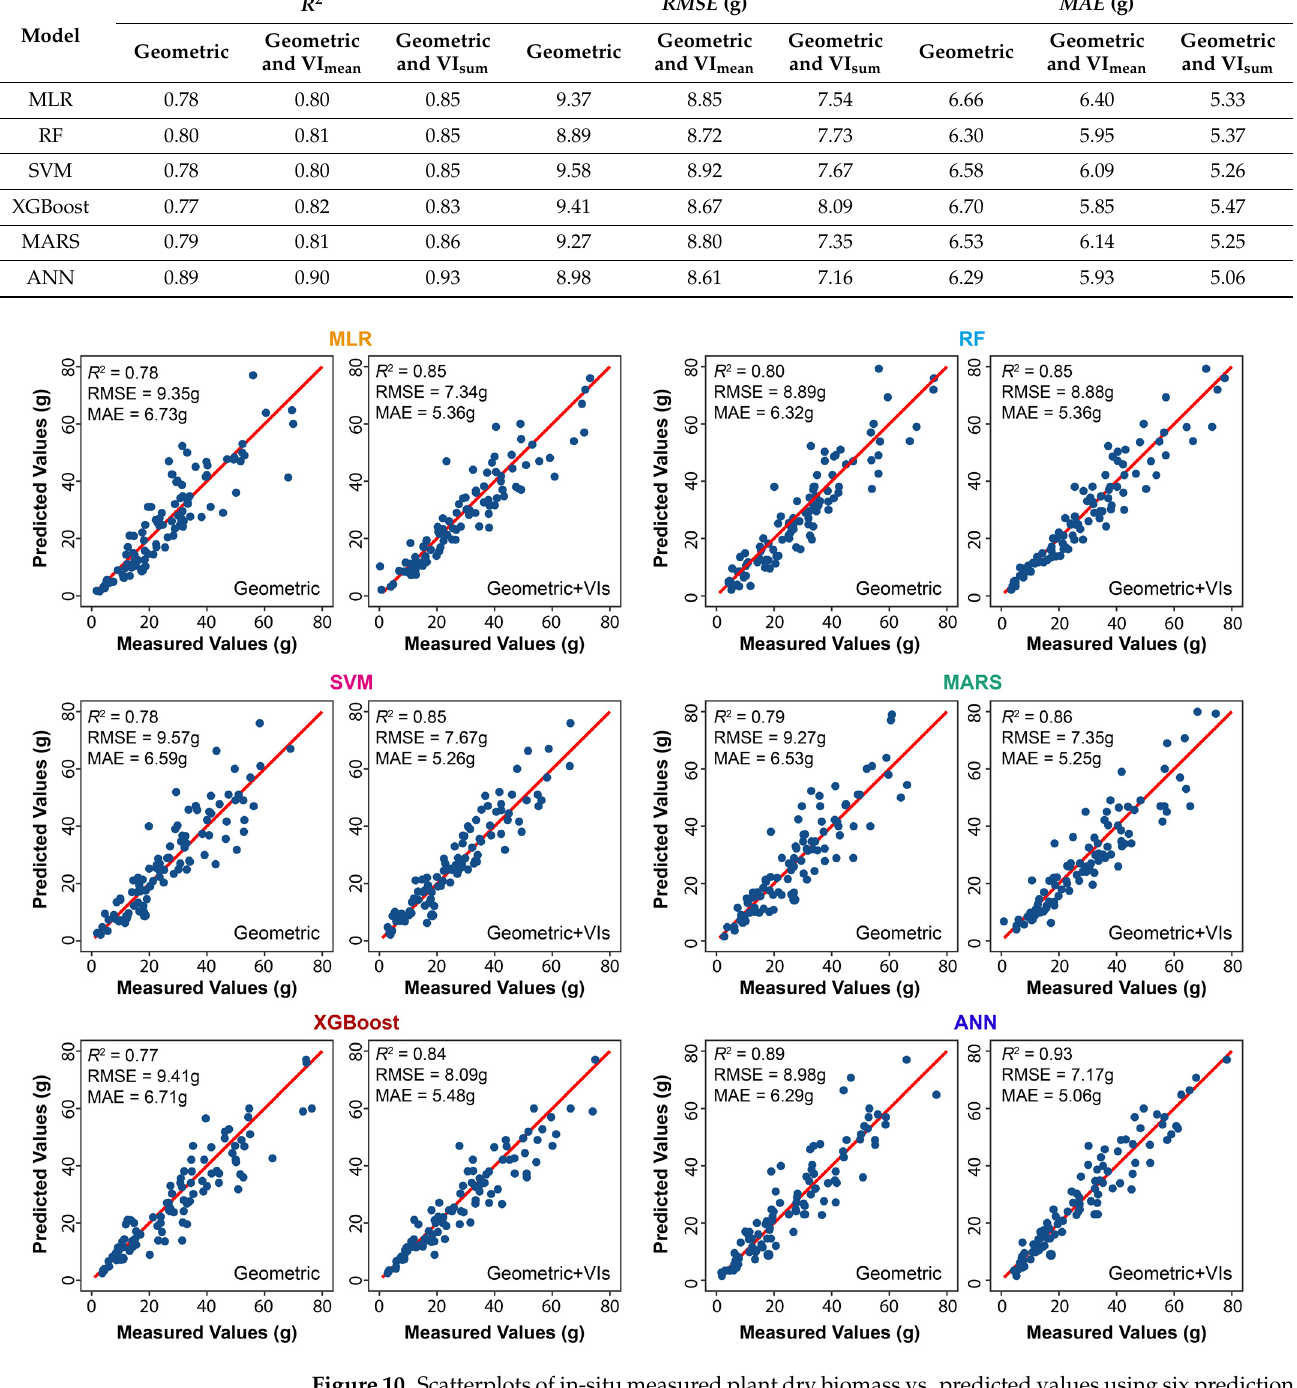
Figure 10. Scatterplots of in-situ measured plant dry biomass vs. predicted values using six prediction models: MLR, RF, SVR, MARS, XGBoost and ANN. For each method, the performance was compared using only geometric parameters and all features (geometric parameters and VI sum variables). Table 4. Average five-fold CV results for the dry biomass models.